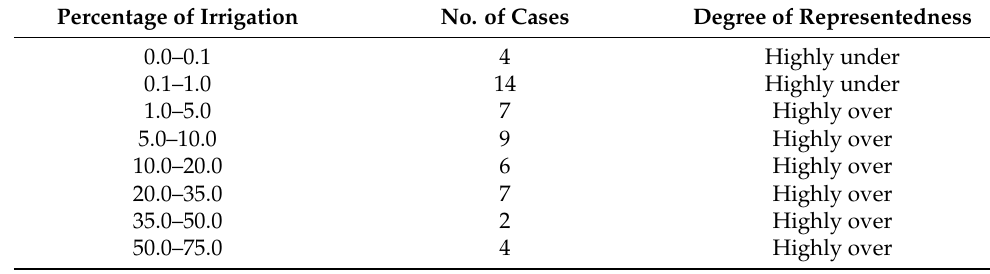
Table 7. Distribution of number of cases based on percentage of irrigation. Percentage of Irrigation No. of Cases Degree of Representedness